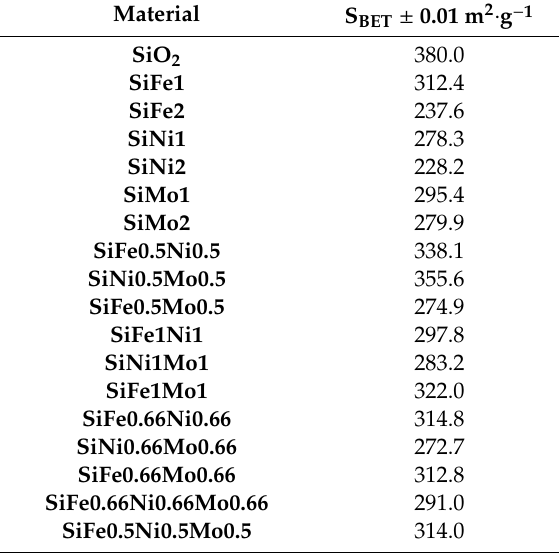
Table 1. Surface area of SiO 2 and nanoparticles functionalized with di ff erent combinations of the transition elements.